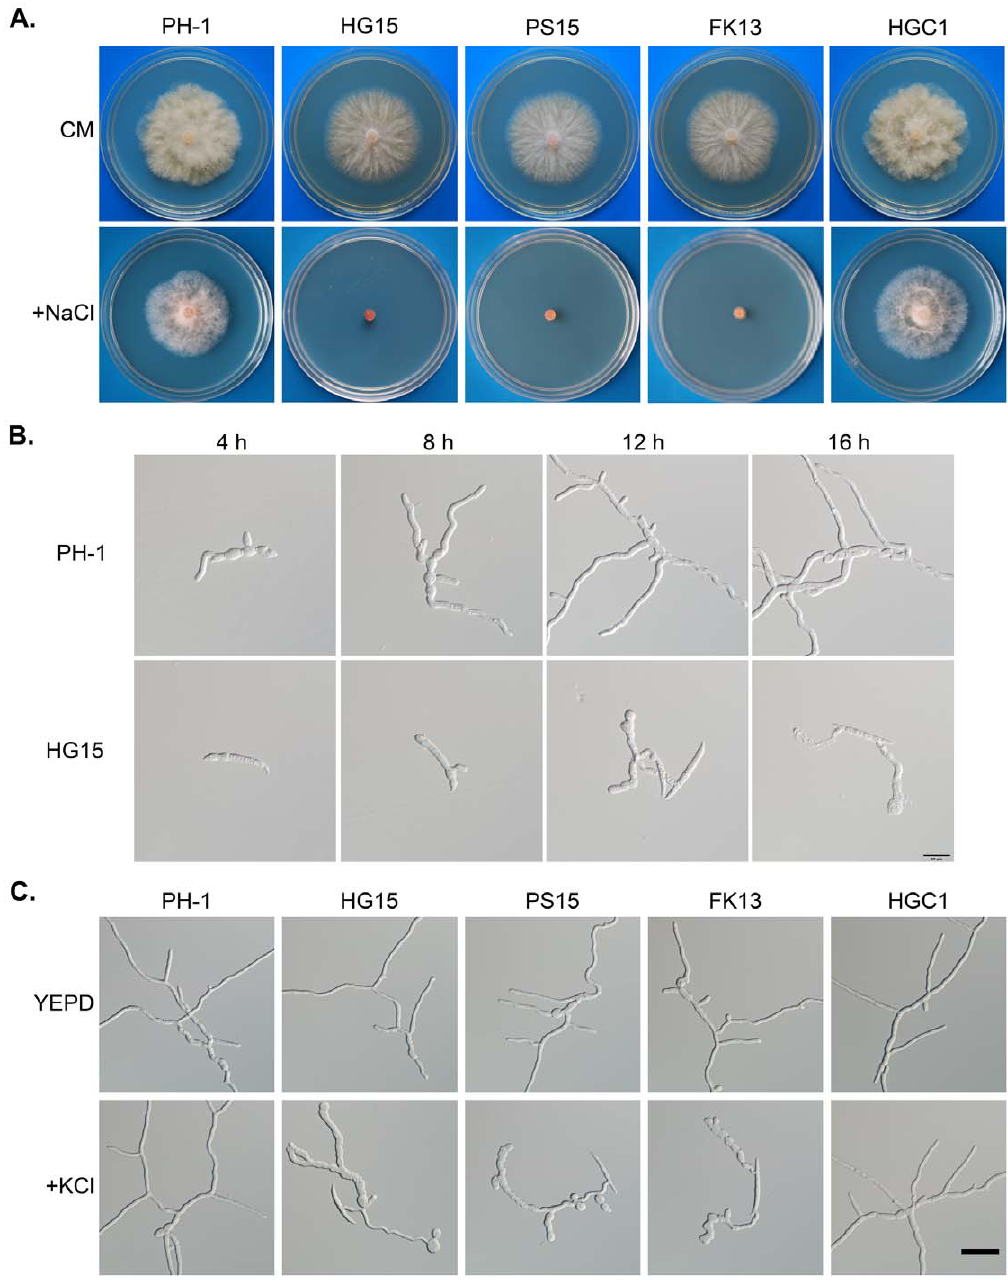
Figure 2. Defects of the Fghog1 , Fgpbs2 , and Fgssk2 mutants in response to hyperosmotic stress. A . Colonies of PH-1, the Fghog1 (HG15), Fgpbs2 (PS15), and Fgssk2 (FK13) mutants, and the Fghog1 / FgHOG1 complemented transformant (HGC1) on CM plates with or without 1 M NaCl. B . Conidium germination of PH-1 and the Fghog1 mutant in CM with 0.7 M NaCl examined at 3 h, 12 h, and 18 h. Bar=20 m m. C . Germlings of PH-1, HG15, PS15, FK13, and HGC1 incubated in CM + 1 M KCl for 12 h. Bar=40 m m. abundant perithecia with cirrhi two weeks after self-fertilization, perithecium formation was not observed in the mutant cultures incubated under the same conditions (Fig. 4A). Instead of sexual development, the FgHog1 pathway mutants appeared to be stimulated for asexual reproduction on fertilized carrot agar plates. Mutant cultures produced abundant conidia and sporodochia but lacked protoperithecium development.